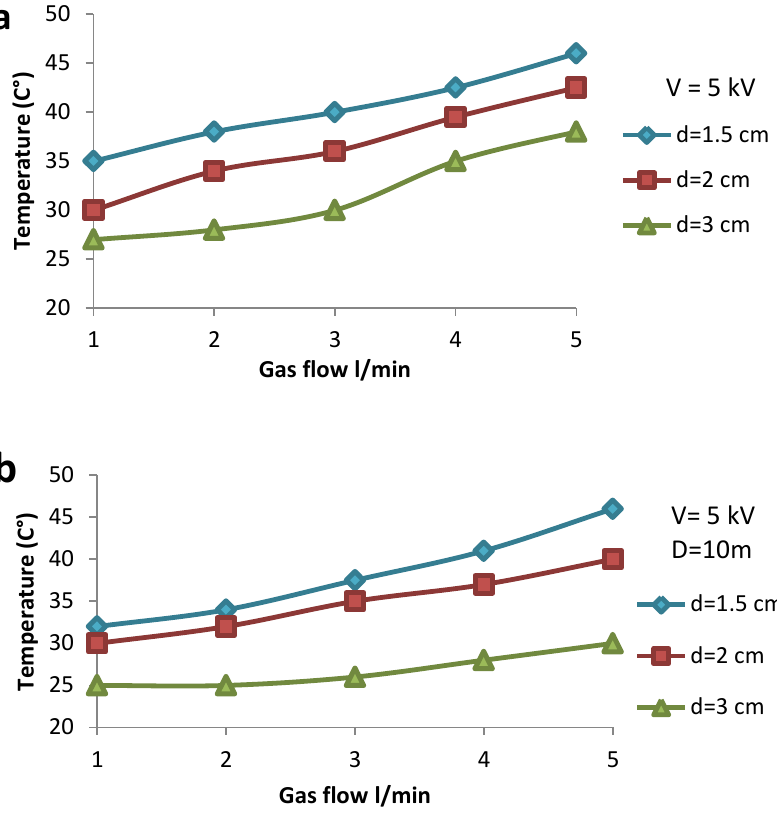
Fig. 4: The relationship between the gas temperature as a function of the gas flow rate for different diameters of the plasma tube (a: 3 mm, b: 10